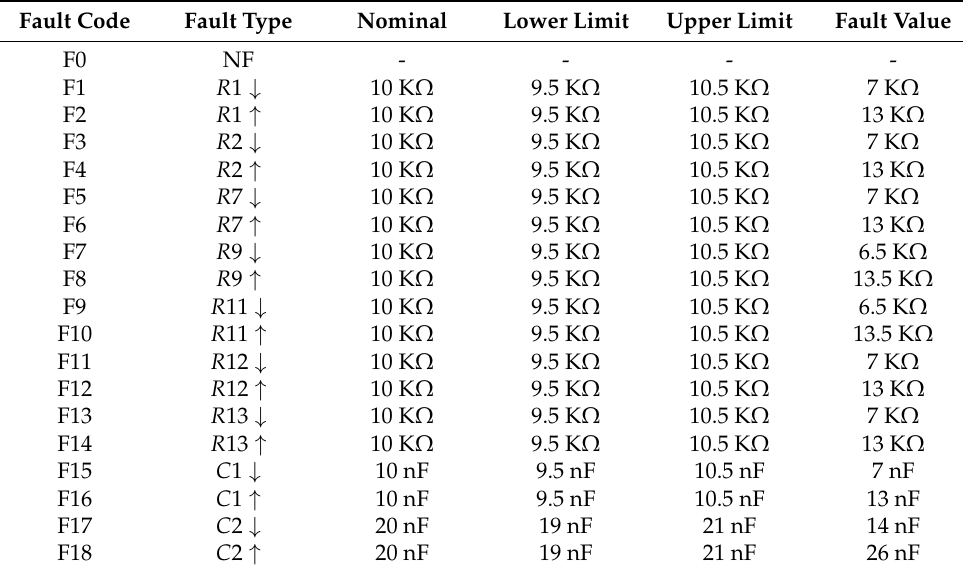
Table 3. Leap-frog low-pass filter circuit fault settings.